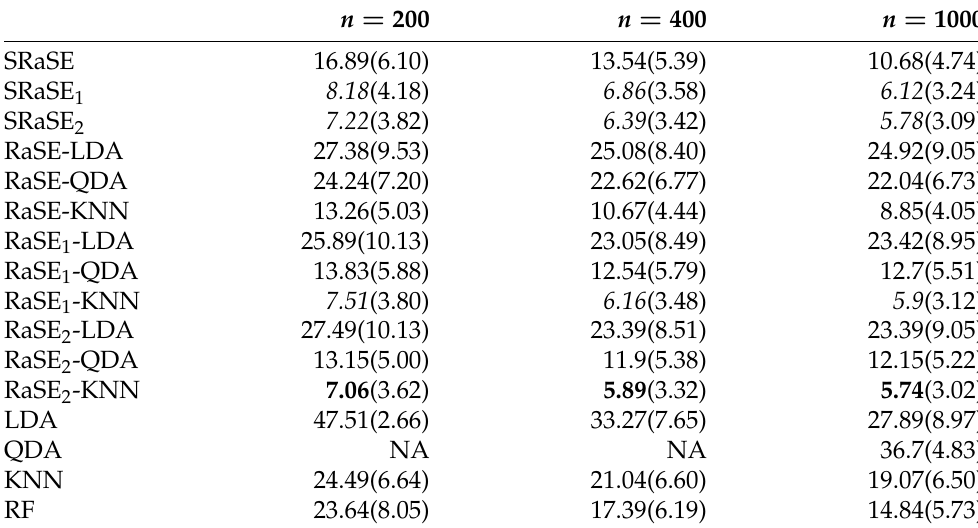
Table 3. Summary of test classification error rates for each classifier under various sample sizes over 200 repetitions in Model 3 (KNN). The results are presented as mean values with the standard deviation values in parentheses. Here, the best performing method in each column is highlighted in bold and the methods that are within one standard deviation away are highlighted in